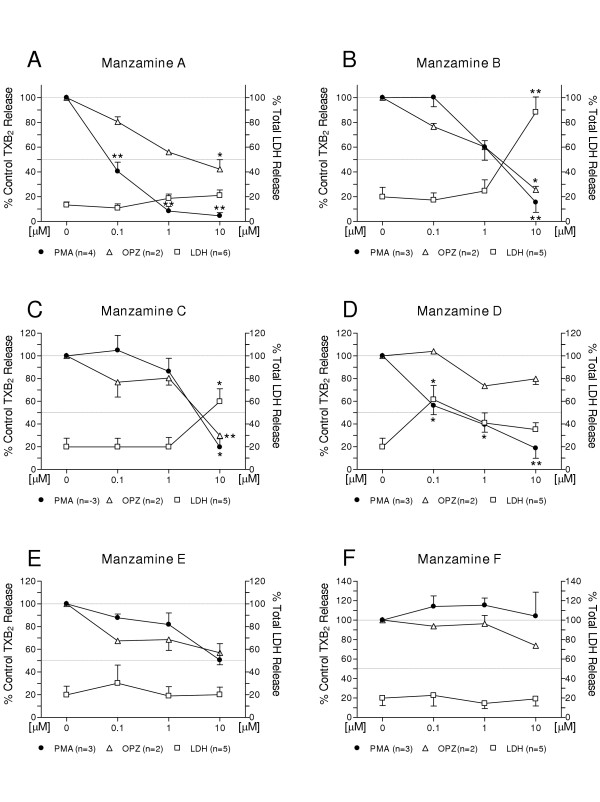
Differential effects of manzamines A, B, C, D, E and F on PMA and OPZ-stimulated TXB2 generation by LPS-activated rat neonatal microglia. Rat neonatal microglia (200,000 cells/well) were activated with LPS (0.3 ng/mL) for 17 hours. Manzamines were added 15 min before stimulation with either PMA (1 μM) or OPZ (0.5 mg/mL). After 70 min, agonist-triggered TXB2 was measured as described in Materials and Methods. LDH release, indicator of cytotoxicity, was determined as described in Materials and Methods. Data are expressed as percentage of control TXB2 release triggered by either PMA (MZA: 1,423 ± 439 pg TXB2 /70 min; MZB, C, D, E, F: 3,279 ± 281 pg TXB2 /70 min), or OPZ (4,504 ± 308 pg TXB2 /70 min). Data show mean ± SEM of indicated number (n) of experiments. * P < 0.05, ** P < 0.01.